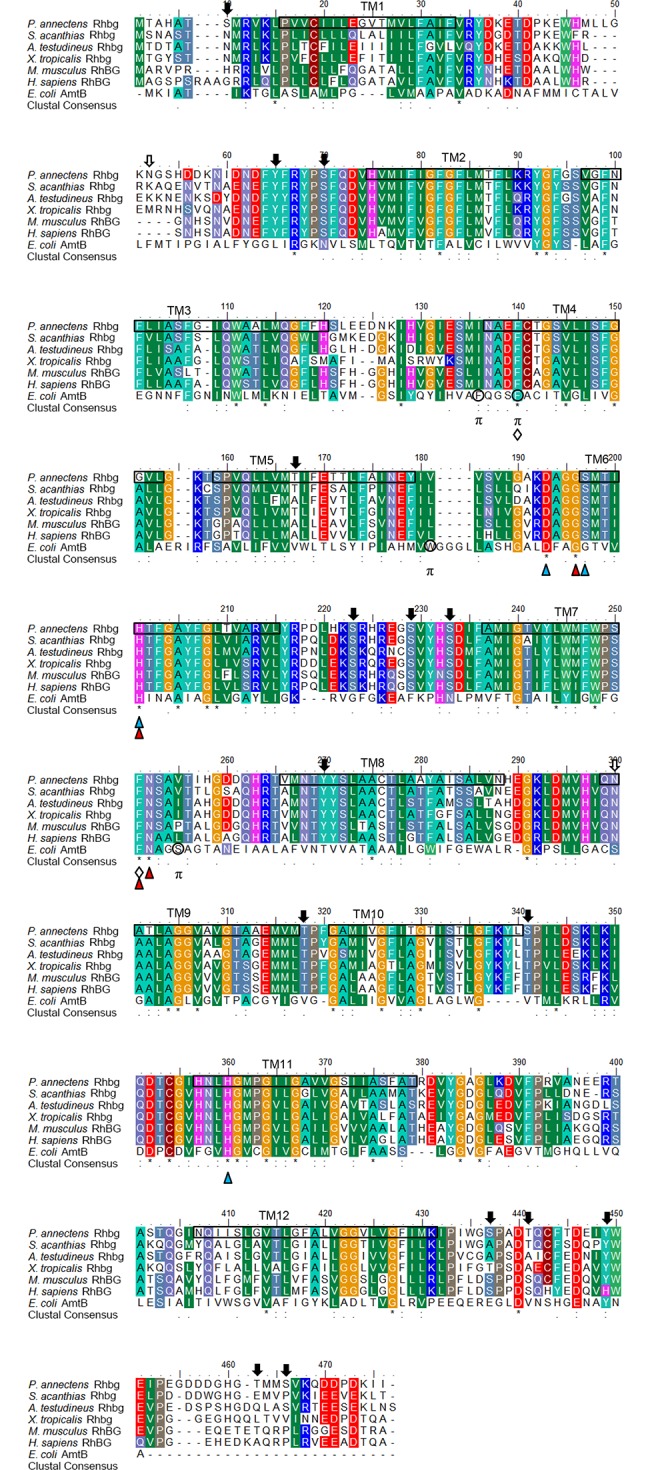
Molecular characterization of Rhesus family B glycoprotein (Rhbg) from the gills of Protopterus annectens.A multiple amino acid alignment of Rhbg from Protopterus annectens with Squalus acanthias Rhbg (AJF44128.1), Anabas testudineus Rhbg (AIC81182.1), Xenopus (Silurana) tropicalis Rhbg (AAU89493.1), Mus musculus RhBG (AAF19371.1), Homo sapiens RhBGA (NP_000315.2) and Escherichia coli ammonia transporter (AmtB; NP_414985.1). Identical amino acid residues are indicated by asterisks, strongly similar amino acids are indicated by colons and weakly similar amino acids are indicated by periods. Residues involved in NH4+ binding and deprotonation of NH4+ for NH3 conduction are indicated by red and blue triangles, respectively. The phenylalanine gate is indicated by open diamonds. The π cation binding sites of E. coli AmtB are indicated by “π”. Potential N-glycosylation and phosphorylation sites are indicated by open and shaded arrows, respectively. The predicted transmembrane domains (TM1‒12) of Rhbg of P. annectens are indicated by open boxes and were predicted using MEMSATS and MEMSAT-SVA provided by PSIPRED protein structure prediction server.